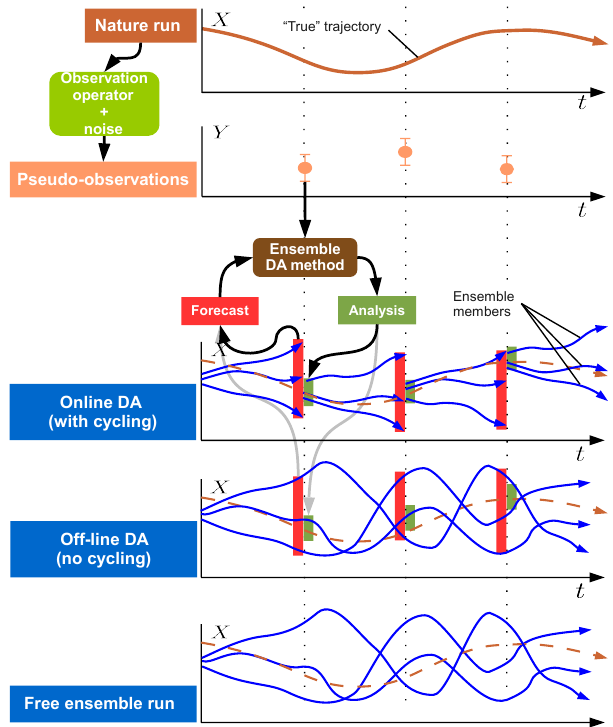
Figure 1. Schematic of a typical observation system simulation experiment (OSSE) with ensemble online (with cycling) and off- line (no-cycling) DA methods. t designates the time axis and X ( Y ) denotes the model state (observation) space. Boxes with sharp (rounded) corners represent data (processes). Red (green) vertical bars indicate the forecast ( analysis ) spread. Vertical dotted lines rep- resent the assimilation steps.